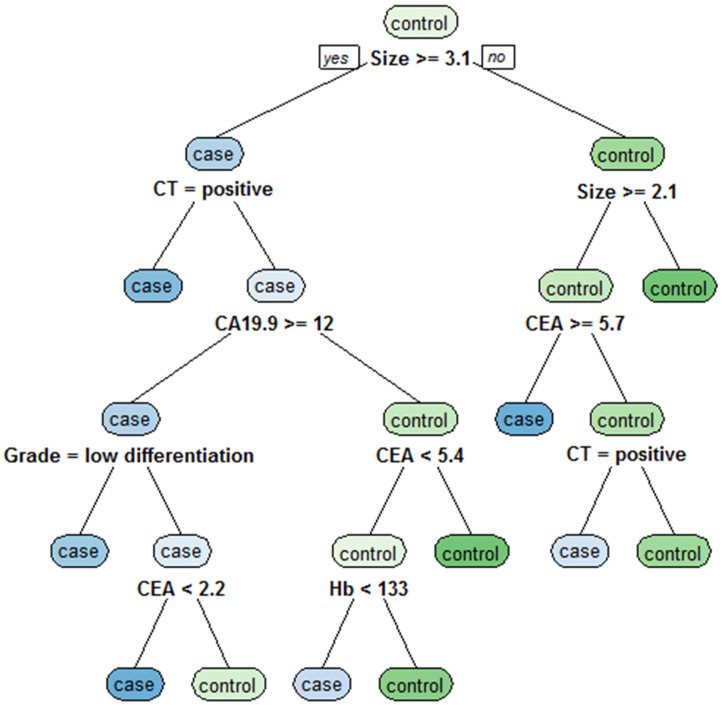
Classification tree for detecting undiagnosed LNM in GC, including tumor size, CT findings, grade, Hb, CEA, and CA19-9. Tumor size was the most important determinant because it was the first-level split of the two initial branches of the classification tree.